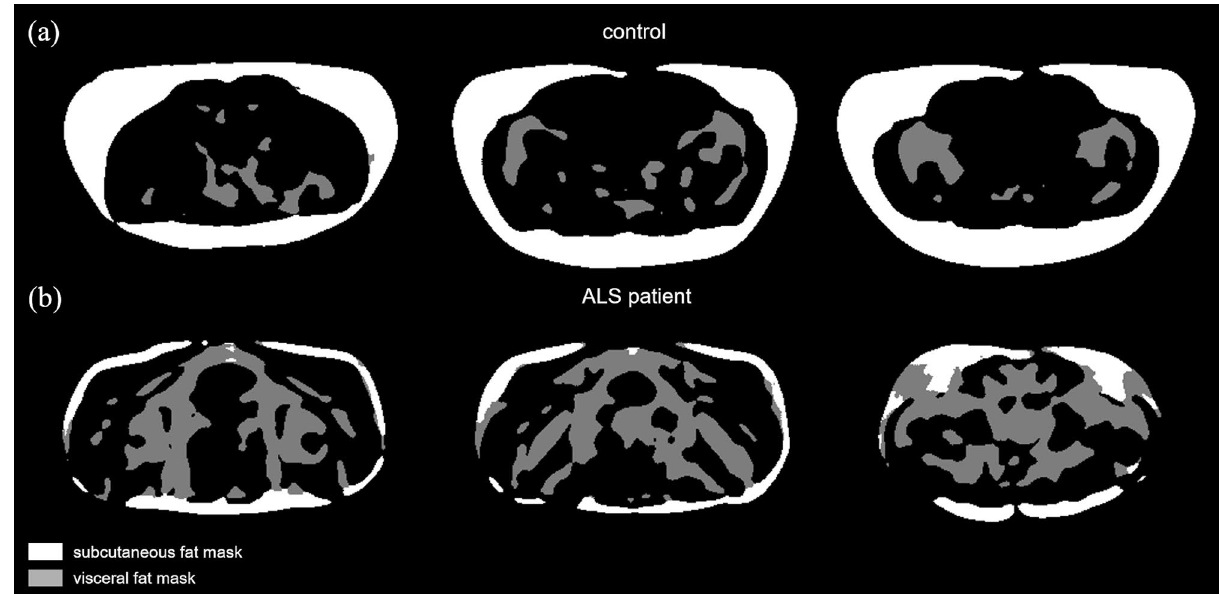
Figure 2. Prediction results on randomly selected test cases. Multi-slice prediction on a dataset from a control ( a ) and from an ALS patient ( b ).